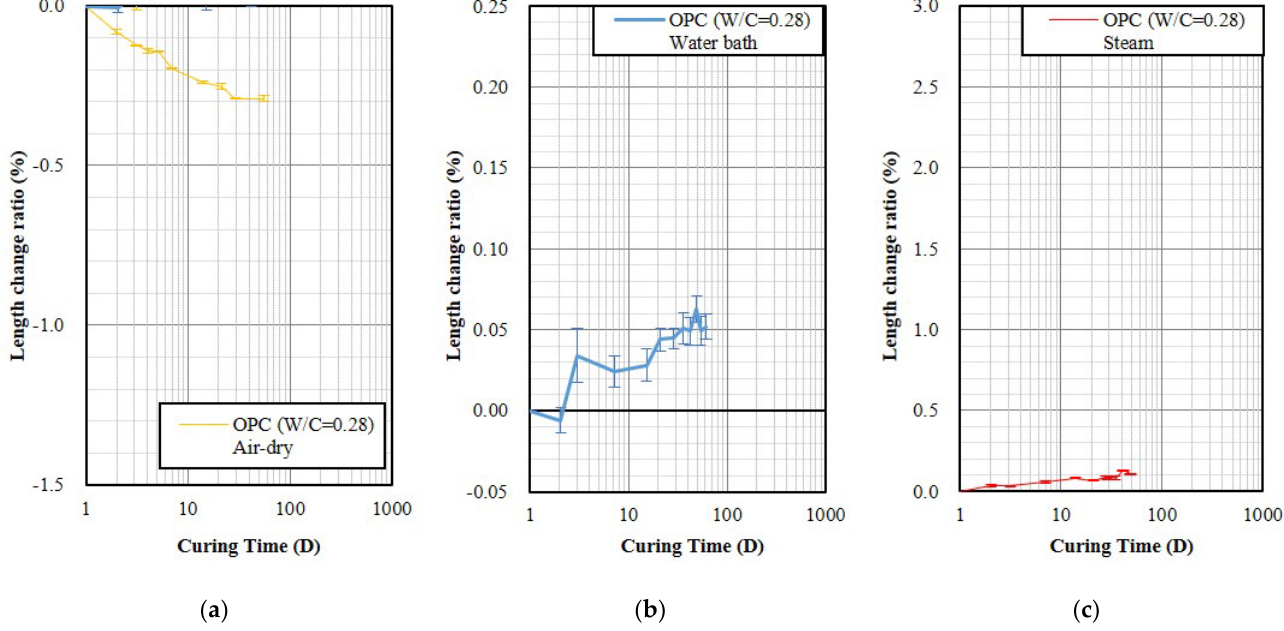
Figure 2. The length change ratios of the OPC specimens demold at age of 24 h and then cured in 3 environments. ( a ) Air-dry; ( b ) Water bath; ( c ) Steam .